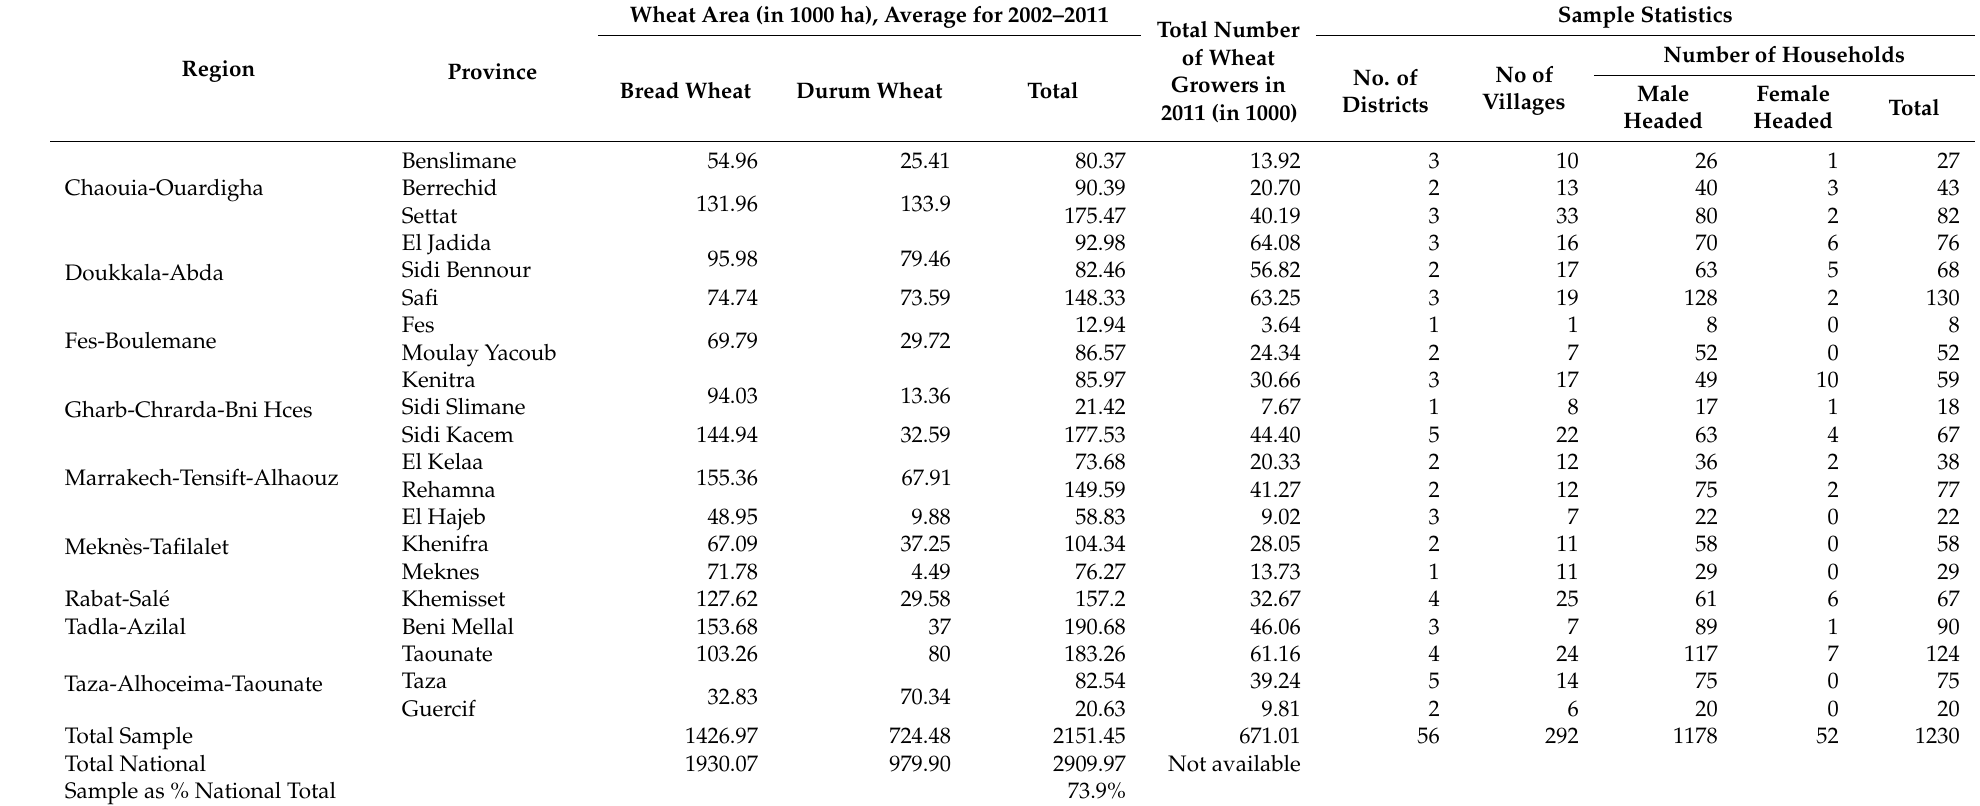
Table 1. Statistics on Wheat Area and Number of Farmers and Distribution of Sample Households across the 21 Provinces.